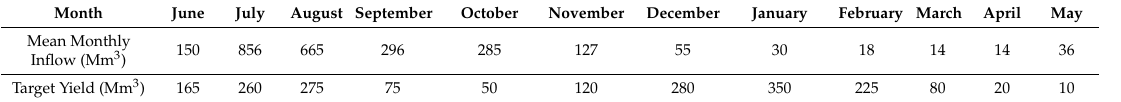
Table 1. Mean monthly inflows and monthly target yields of River Hemavathy.